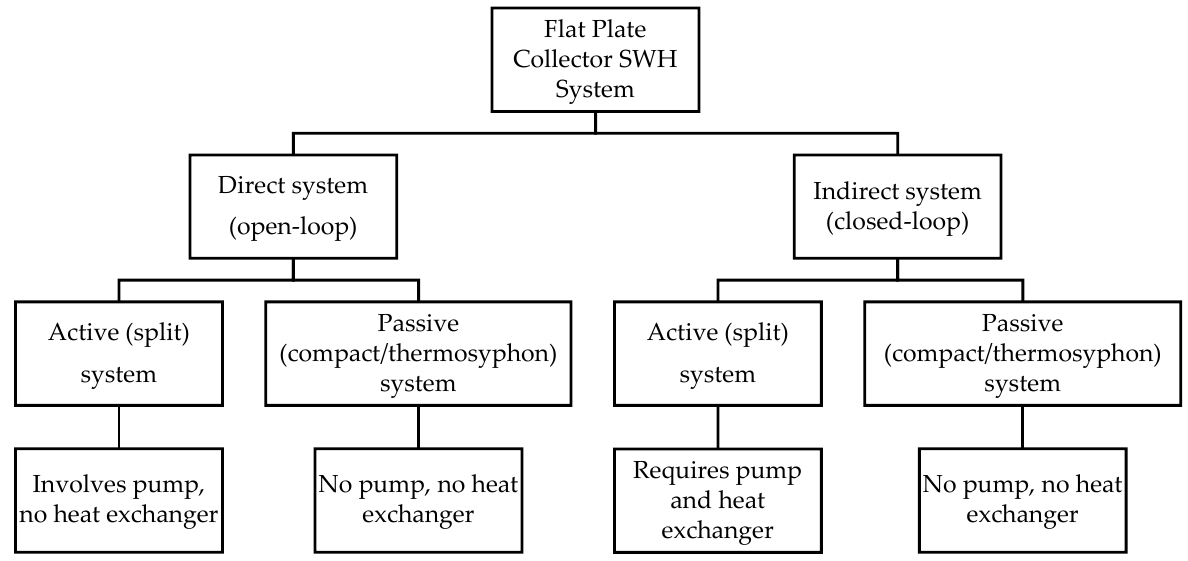
Figure 6. Summary of the different types of FPC-SWH systems.